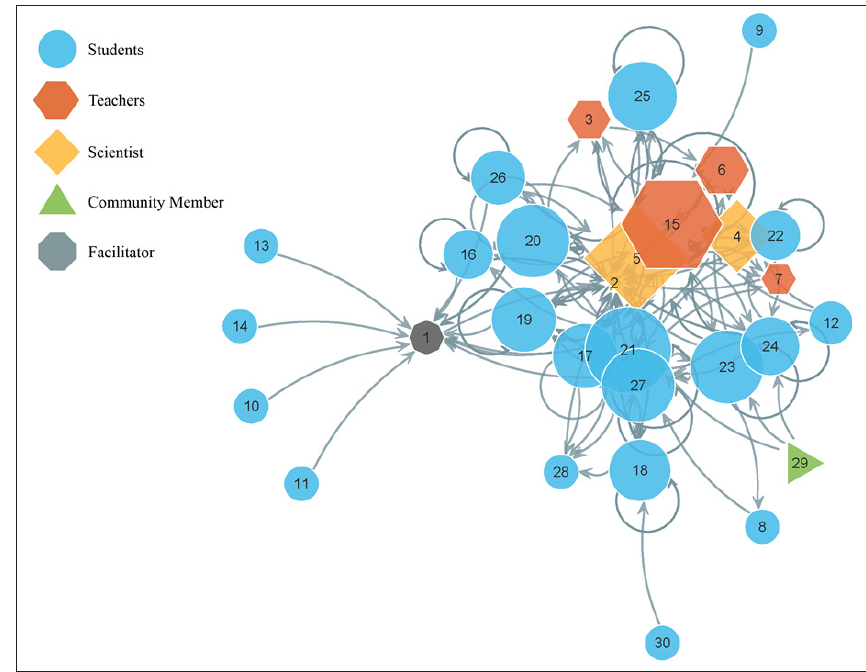
Figure 3: King Tide Investigation Network. Each symbol represents one individual and size is scaled by the number of postings that individual made. Shapes represent user